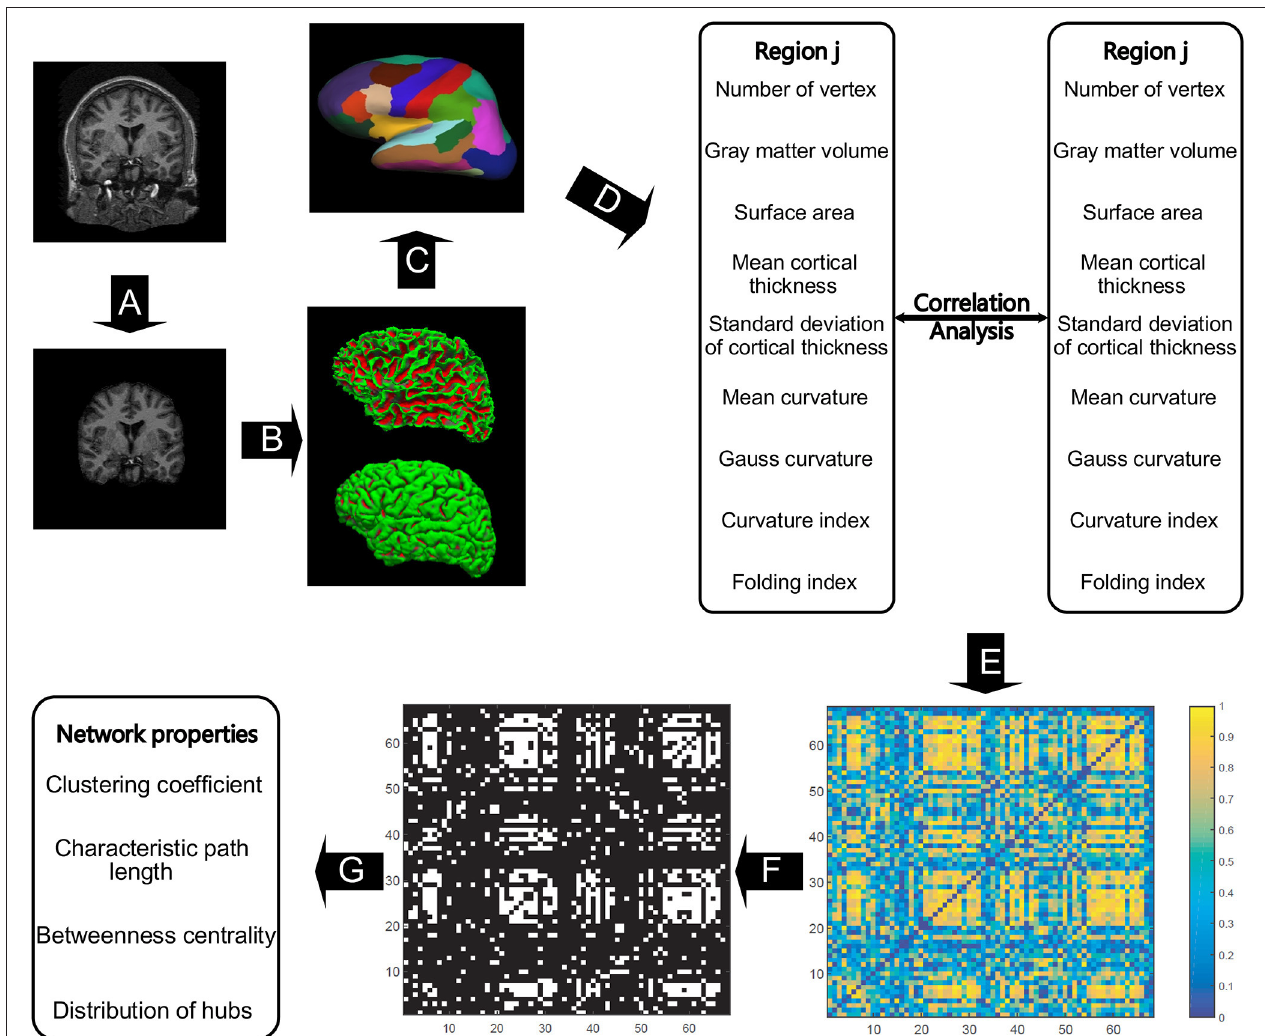
FIGURE 1 | The general flowchart of the individual-based morphological brain network construction and analyses. The steps from (A–D) were accomplished using FreeSurfer. Intensity bias was corrected, and the skull was stripped (A) before the inner and outer surfaces of gray matter were extracted (B) . All the involved morphometric features were first measured between inner and outer surfaces (C) , and then the feature results were mapped to the Desikan–Killiany cortical atlas to obtain the regional feature measurements (D) . For each region, nine morphometric features were concatenated as a feature vector to obtain the correlation coefficient between any two regions to frame the individual-based morphological connectivity (E) . The connection matrix was then repeatedly binarized based on the sparsities (from 20 to 40% with a step size of 1%) to generate the network graphs (F) , and then the network topological properties were analyzed in accordance with graph theory (G)